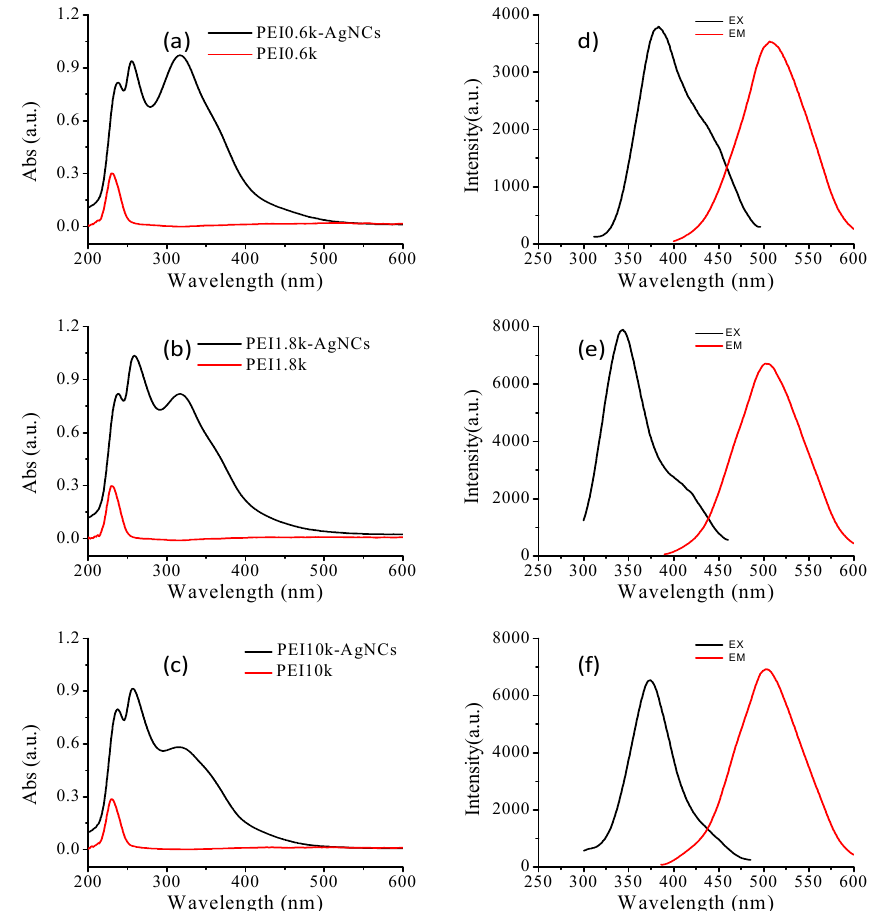
Figure 2. Characterizations of PEI-AgNCs and PEIs with PEI molecular weight from 0.6 kDa to 10 kDa. ( a – c ) The UV-Vis spectra of PEI-AgNCs and PEIs with PEI molecular weight of 0.6 kDa ( a ); 1.8 kDa ( b ) and 10 kDa ( c ). ( d – f ) The excitation and emmision spectra of PEI0.6k-AgNCs ( d ); PEI1.8k-AgNCs ( e ) and PEI10k-AgNCs ( f ), respectively.